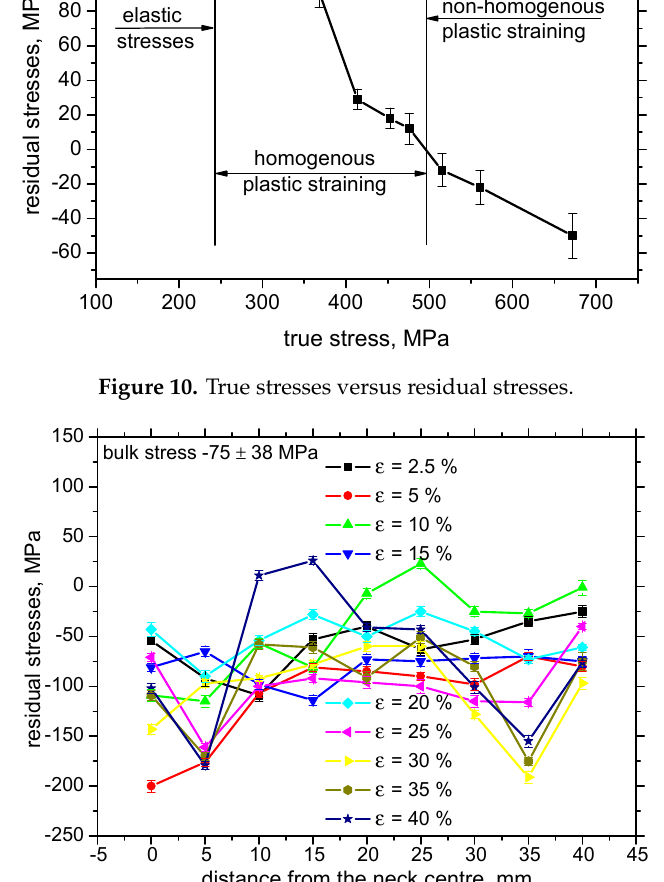
Figure 11. Evolution of residual stresses for the different ε , transverse direction (TD).